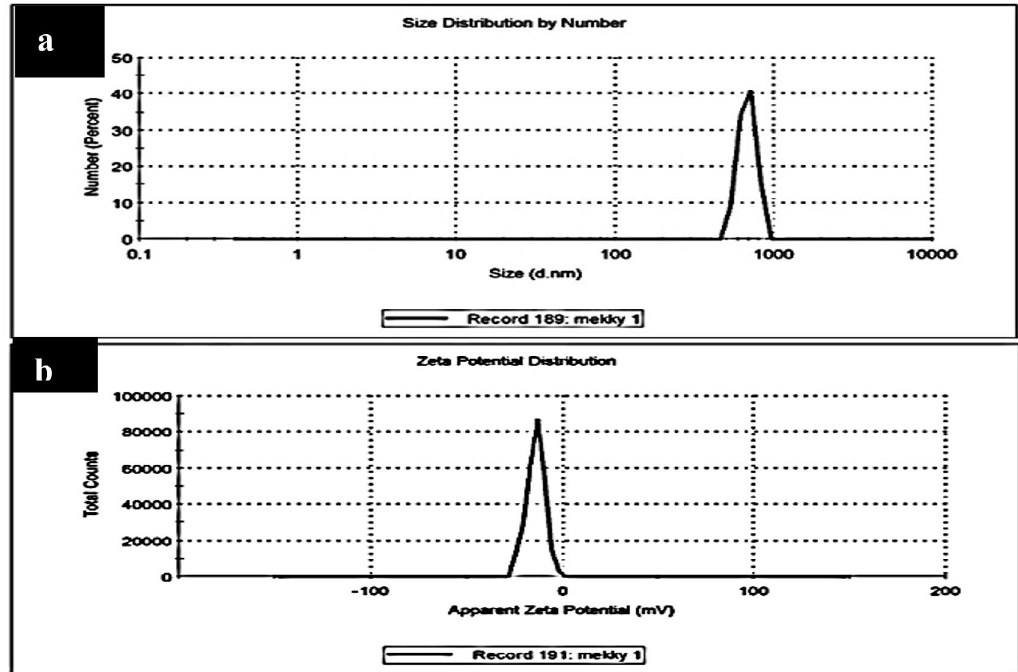
Fig. 7. (a) DLS and (b) Zeta-potential data for green synthesized ZnO NPs using ( A. niger ) extracellular